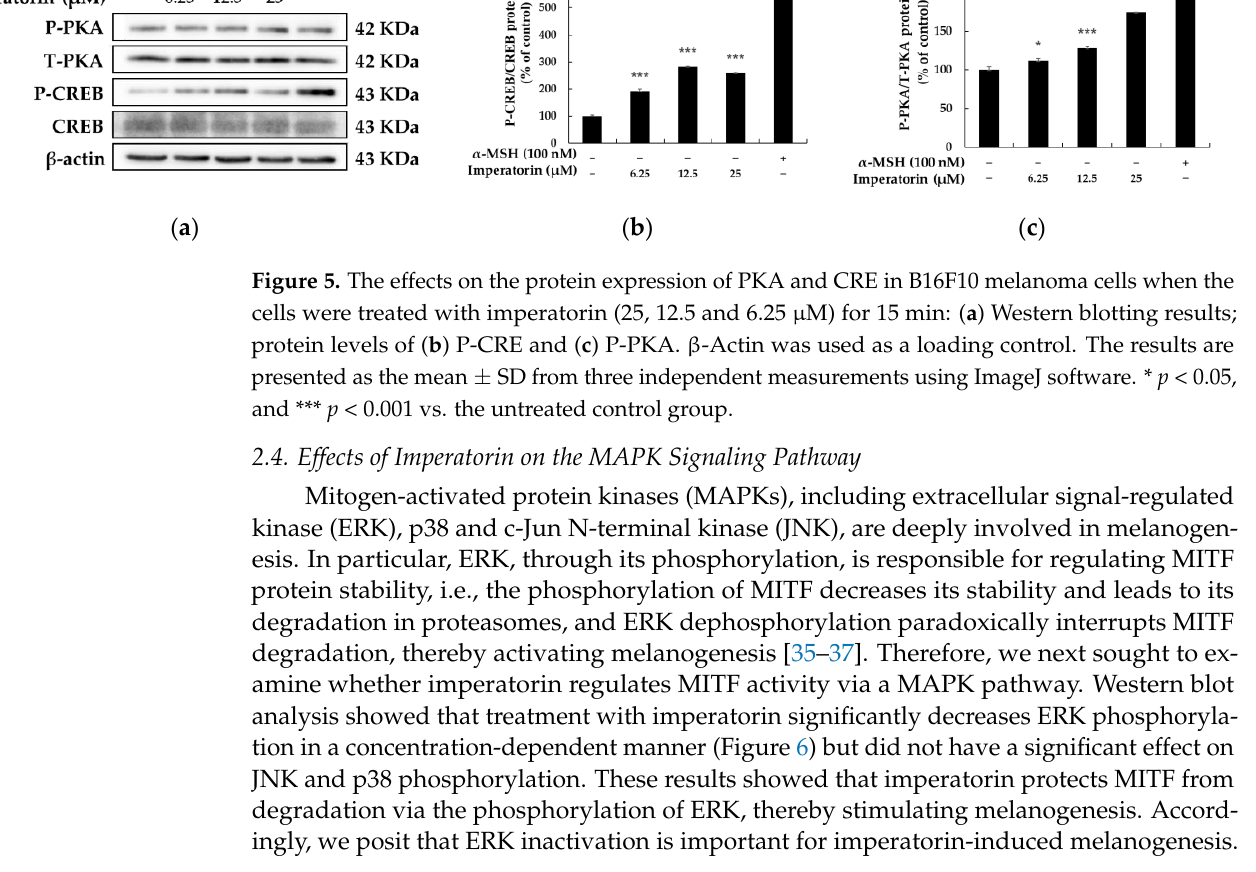
Figure 4. The effects on the protein expression and phosphorylation of MITF in B16F10 melanoma cells when the cells were treated with imperatorin (25, 12.5, and 6.25 μM) for 24 h: ( a ) Western blot- ting results; ( b ) protein levels of MITF; ( c ) phosphorylation level of MITF. β -Actin was used as a loading control. The results are presented as the mean ± SD from three independent measurements using ImageJ software. *** p < 0.001 vs. the untreated control group.